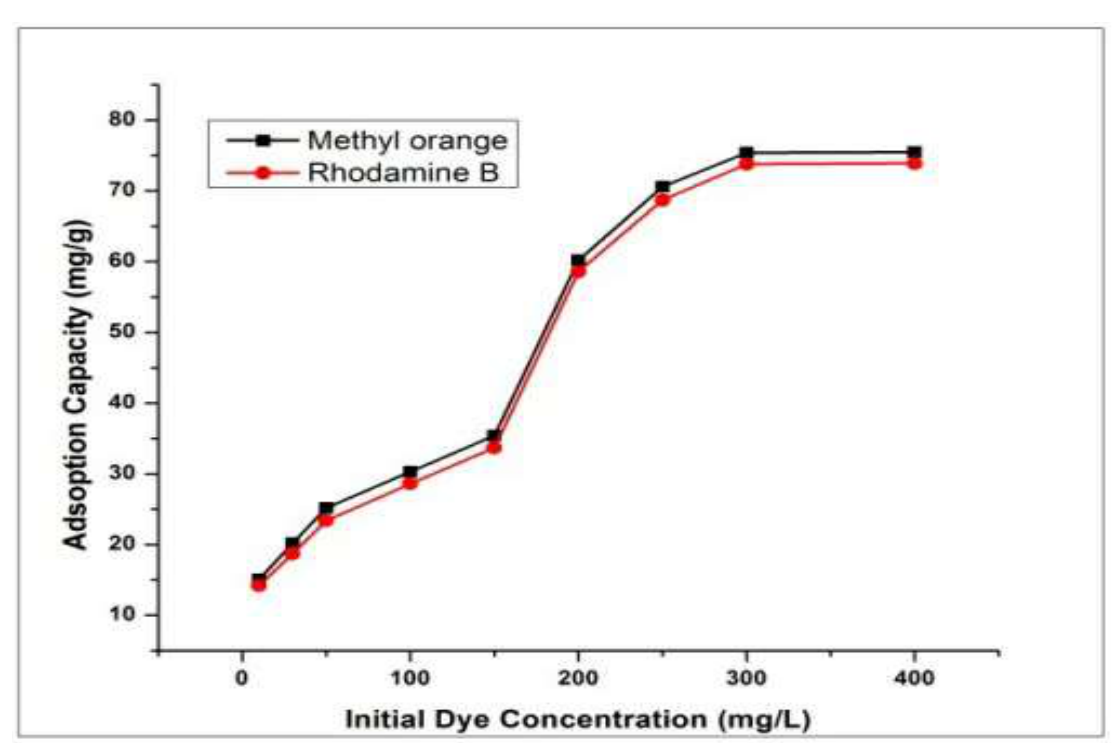
Figure 16. Effect of initial dye concentration on dyes adsorption.